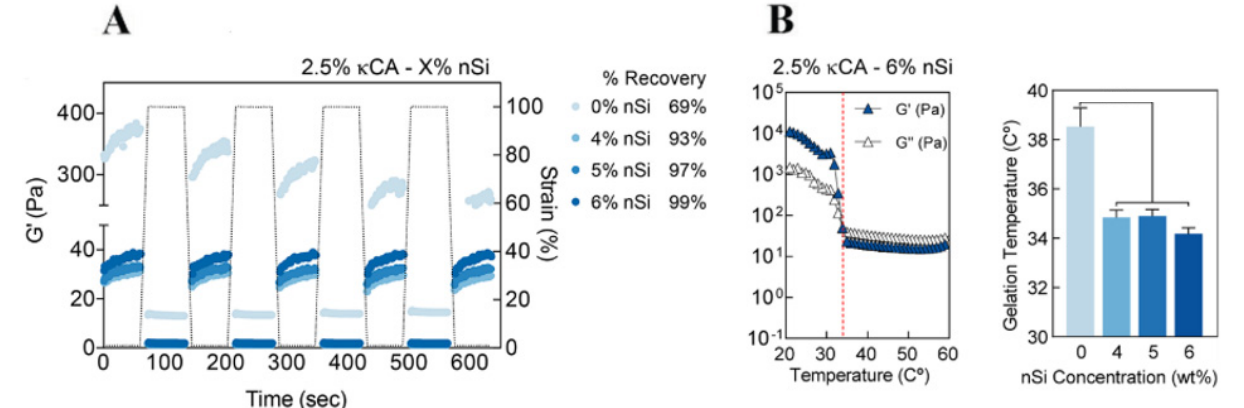
Figure 11 . Rheological changes to the hydrogel with clay addition. ( A ) Percent recovery of kCA − nSi bioink at 37 °C with the introduction of nSi. ( B ) Temperature ramp (60 to 20 °C) to display the gelation of bioink compositions. (Adapted with permission from [63]. Copyright 2017, American Chemical Society).